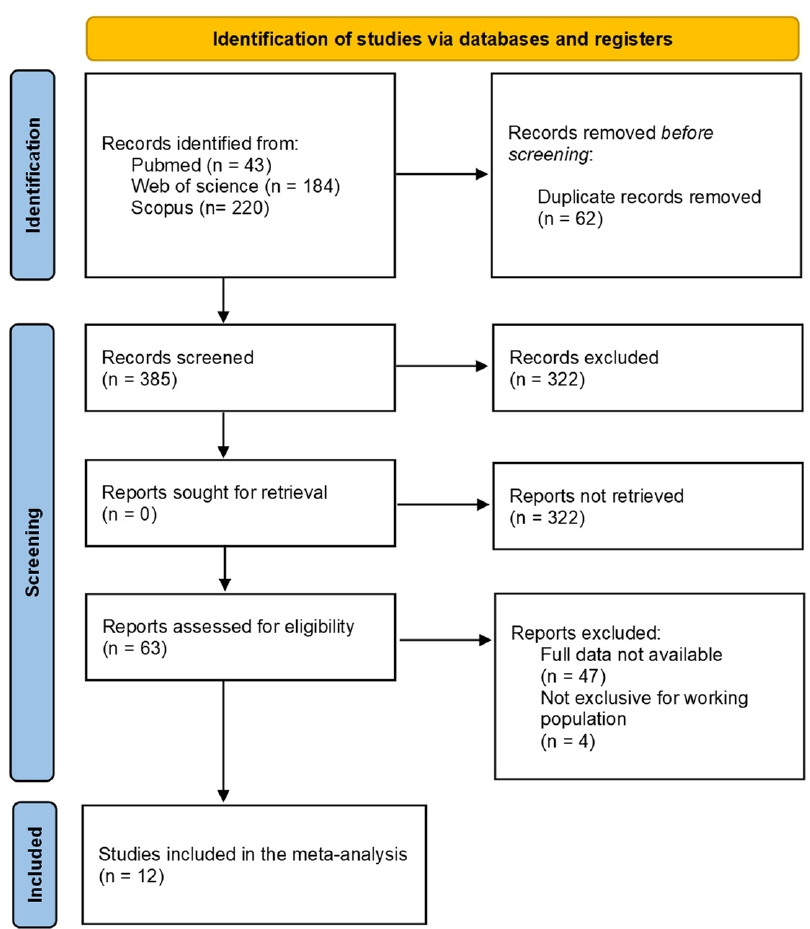
Figure 1. PRISMA flow-chart diagram.